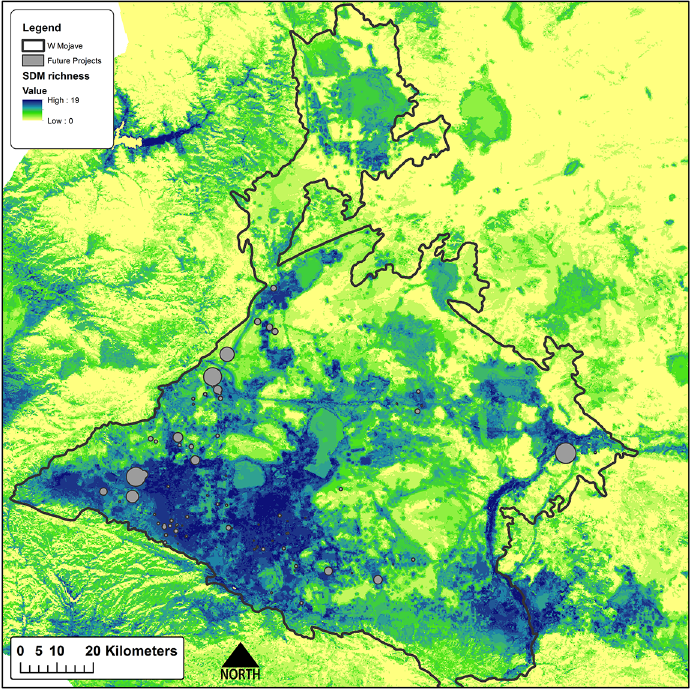
Fig 3. Proposed solar development sites. Western Mojave ecological subsection with species richness and proposed utility scale solar development locations. Species richness is based on SDMs described in Davis et al.